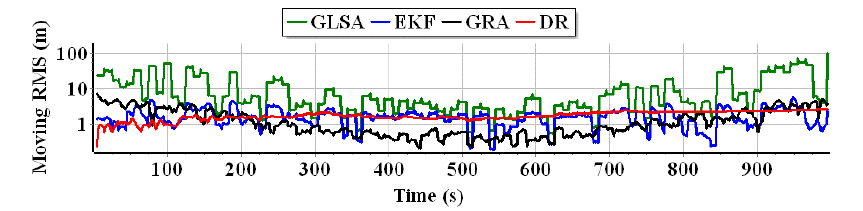
Figure 11. Moving RMS of the distance to the reference position from the estimated position during a single SV crossing as a function of time.